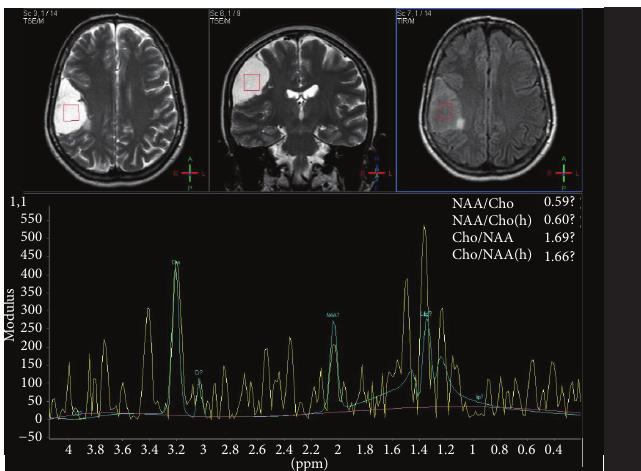
Figure 1: CT scan of the brain. A hypodense, extra-axial image is observed(asterisk),intherightfrontoparietalregionwhichimprints over the adjacent brain parenchyma. Lesion hypodensity is similar to the cerebrospinal fluid. A small mural hyperdense nodule (red arrow) is also identified.